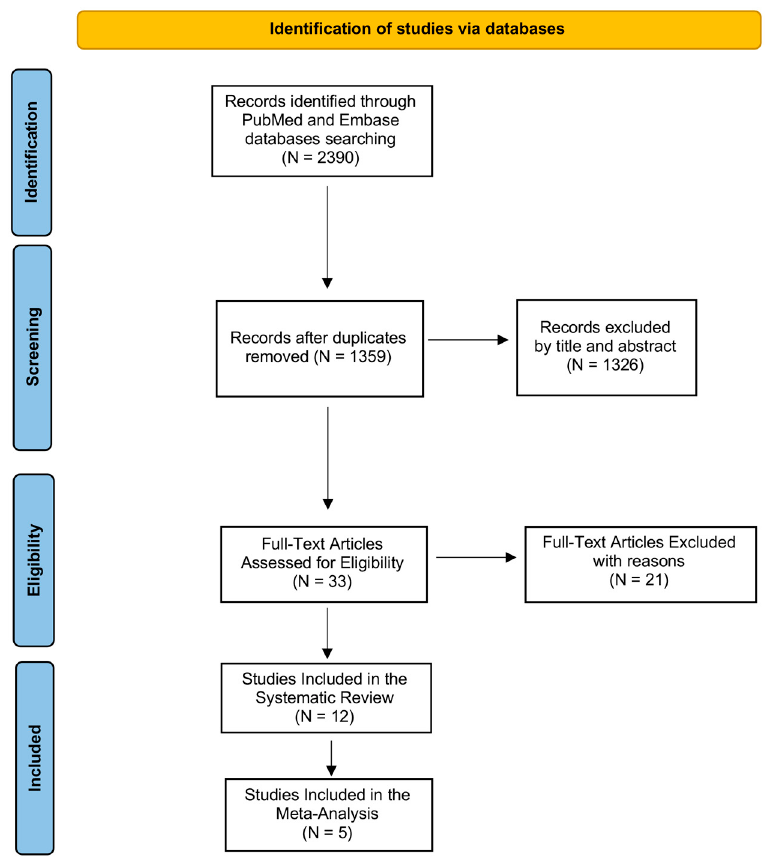
Figure 1. PRISMA flow diagram. The figure describes every step of search strategy and screening, all process was performed according to PRISMA-P guidelines.